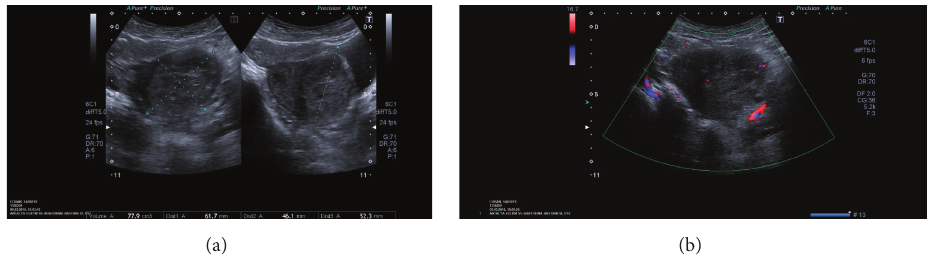
Figure 3: A repeat transvaginal ultrasound and color Doppler were done two months later; (a) the lesion was measuring 61 ∗ 46 ∗ 52 mm (77 cm 3 ) and (b) revealed no blood